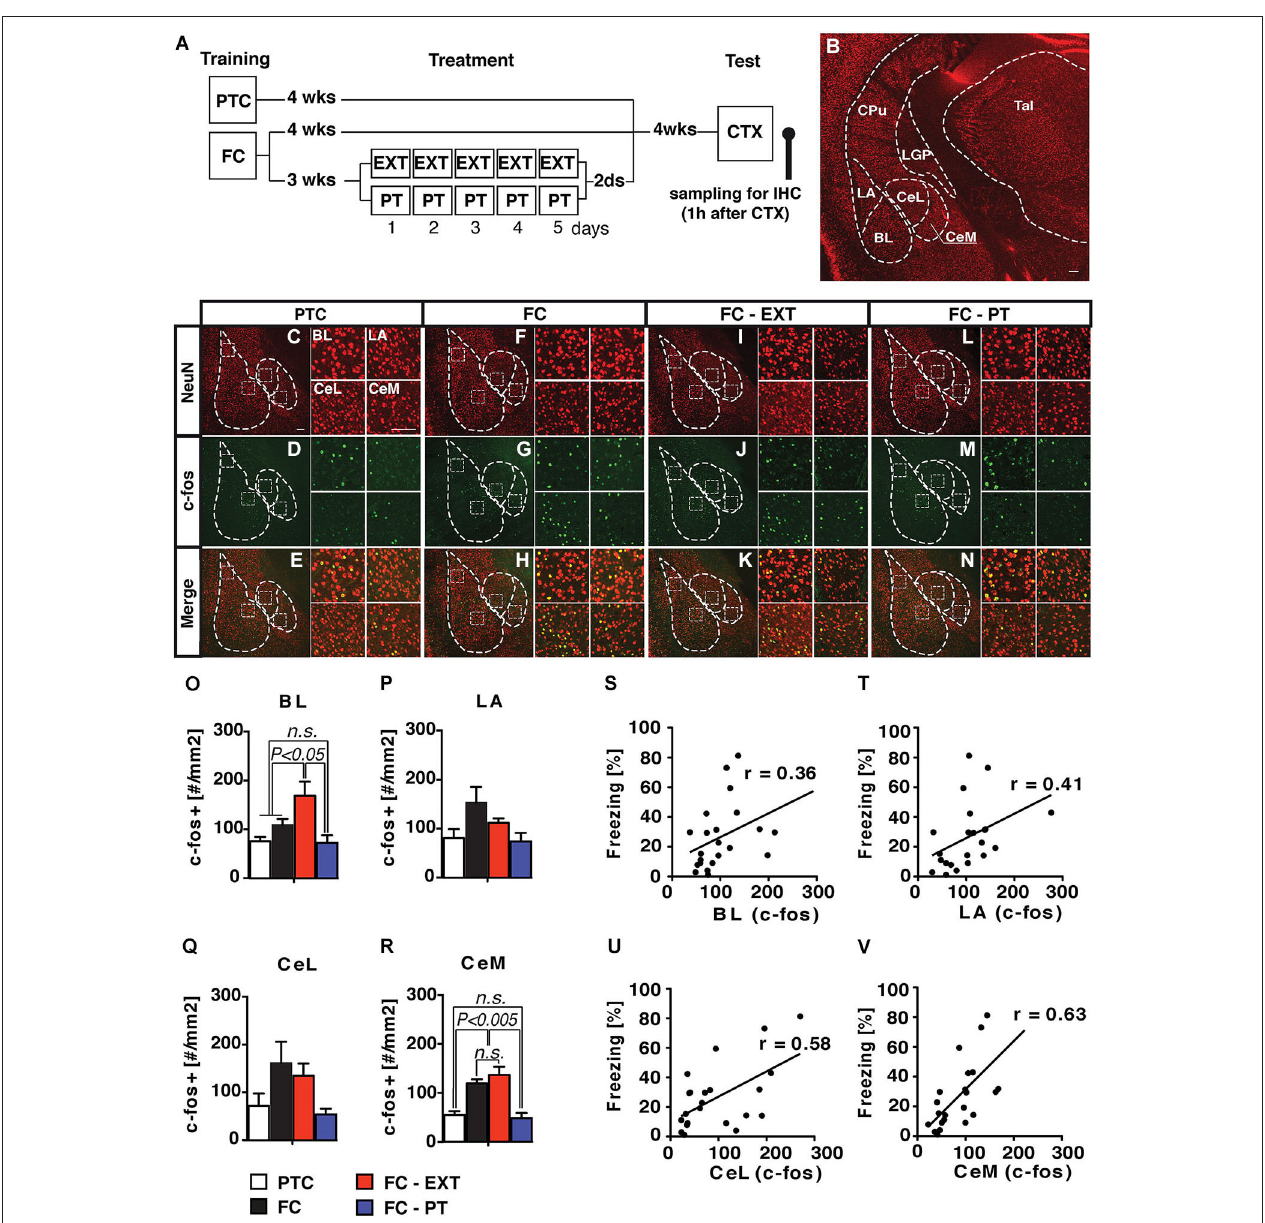
4 weeks after treatment. BL, LA, CeL and CeM high magnification insets box. Scale bars = 100 µ m. ( O–R ) Analyses of c-fos labelled neurons (#/mm 2 ) for each experimental group (PTC, n = 7; FC, n = 5; FC-EXT, n = 4; FC-PT, n = 5). ( S–V ) Regression analysis between freezing during CTX and the number of c-fos labeled neurons for each amygdala subdivision. Vertical bars represent SEM. Results of individual post hoc comparisons (Duncan’s and Fisher’s tests) are depicted in the figure [n.s., not significant = P >